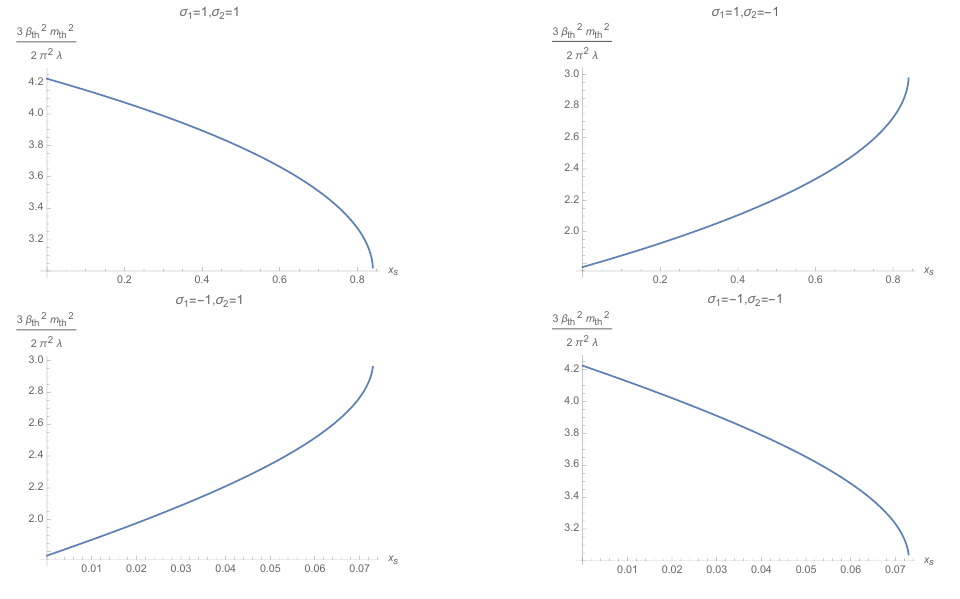
2 2 vs. x for the different fixed th m th s 2 π 2 λ